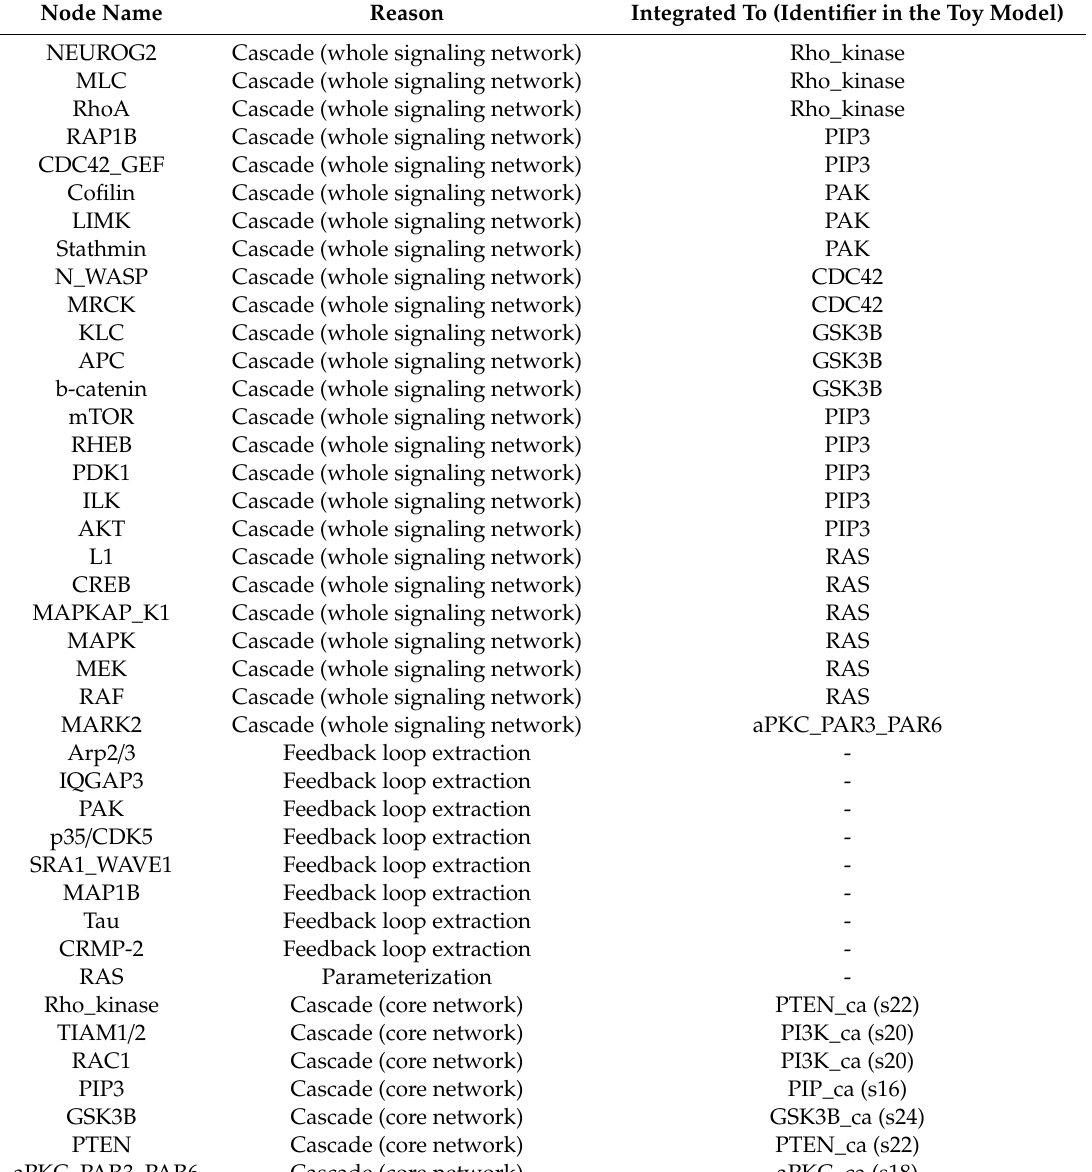
Table A1. Nodes removed by the contraction process.